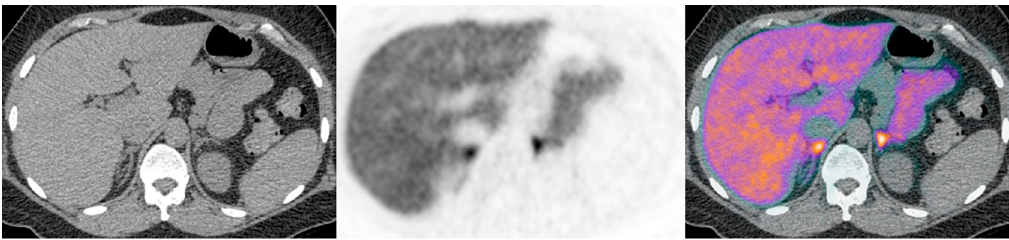
Figure 3. Illustrative case 3: A 42-year-old woman had been diagnosed with hypertension and hypokalaemia 15 years previously in pregnancy. She rotated through trials of various anti-hypertensive medications before achieving reasonable control with spironolactone, together with additional potassium supplementation. A biochemical diagnosis of primary aldosteronism was made following a failure to suppress aldosterone on a saline infusion test. CT findings were equivocal, but with a suggestion of possible subcentimetre nodules bilaterally on CT ( a ). There were no discrete ‘hot nodules’, with symmetrical bilateral uptake on 11 C-metomidate PET-CT ( b , c ). Her bilateral disease is currently managed medically.